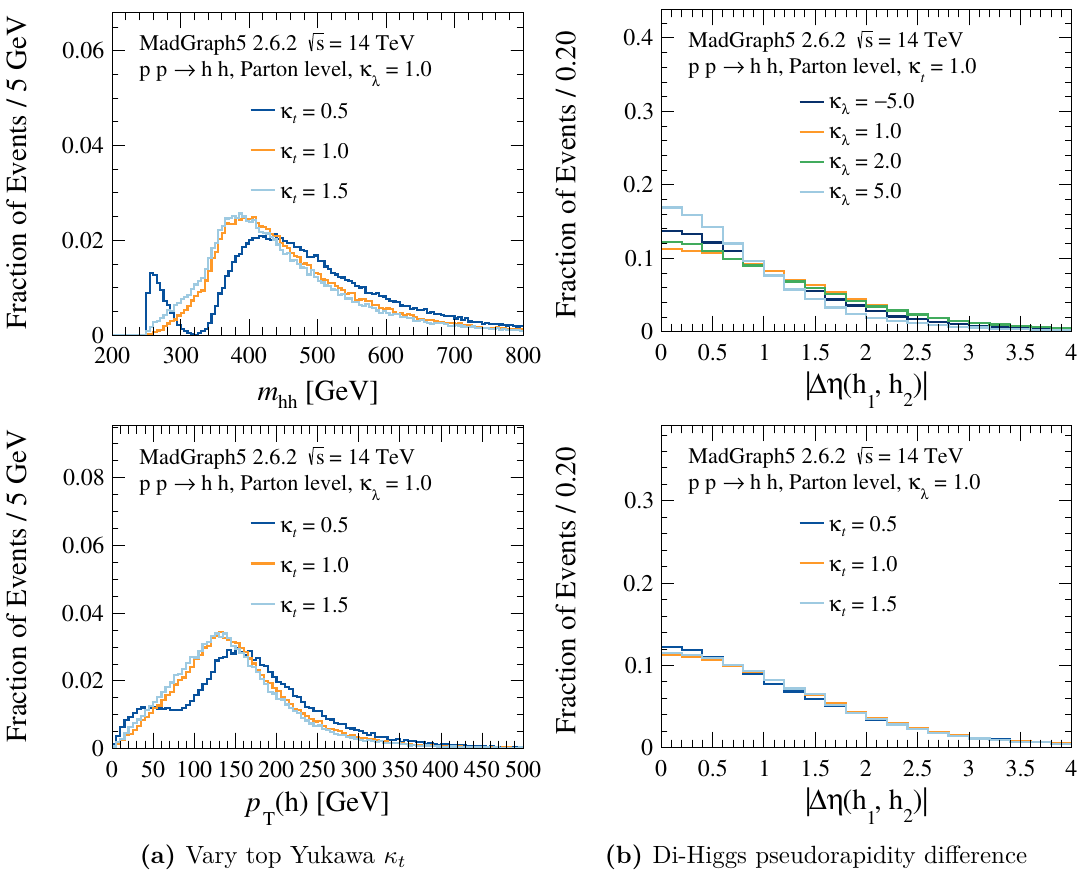
Figure 16. Unit normalised distributions for parton-level signals for different